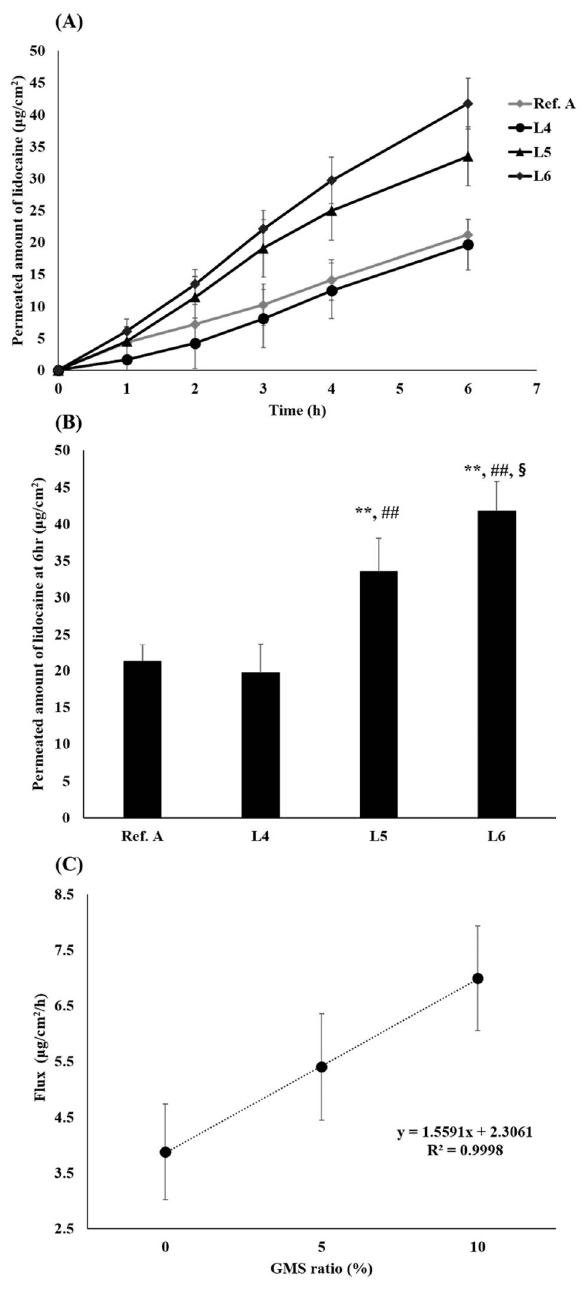
Figure 8. Permeation tests of L4, L5, L6 ointments. ( A ) Permeation profile of prepared lidocaine ointments and reference product A with cadaver skin; ( B ) Permeated amount of lidocaine at 6 h; ( C ) Correlation between flux and GMS ratio (%) (mean ± standard deviation, n = 4). GMS: glycerol monostearate. § ANOVA, LSD, p -value < 0.05 compared with L5 group. ** ANOVA, LSD, p -value < 0.005 compared with Ref. A group. ## ANOVA, LSD, p -value < 0.005 compared with L4 group.